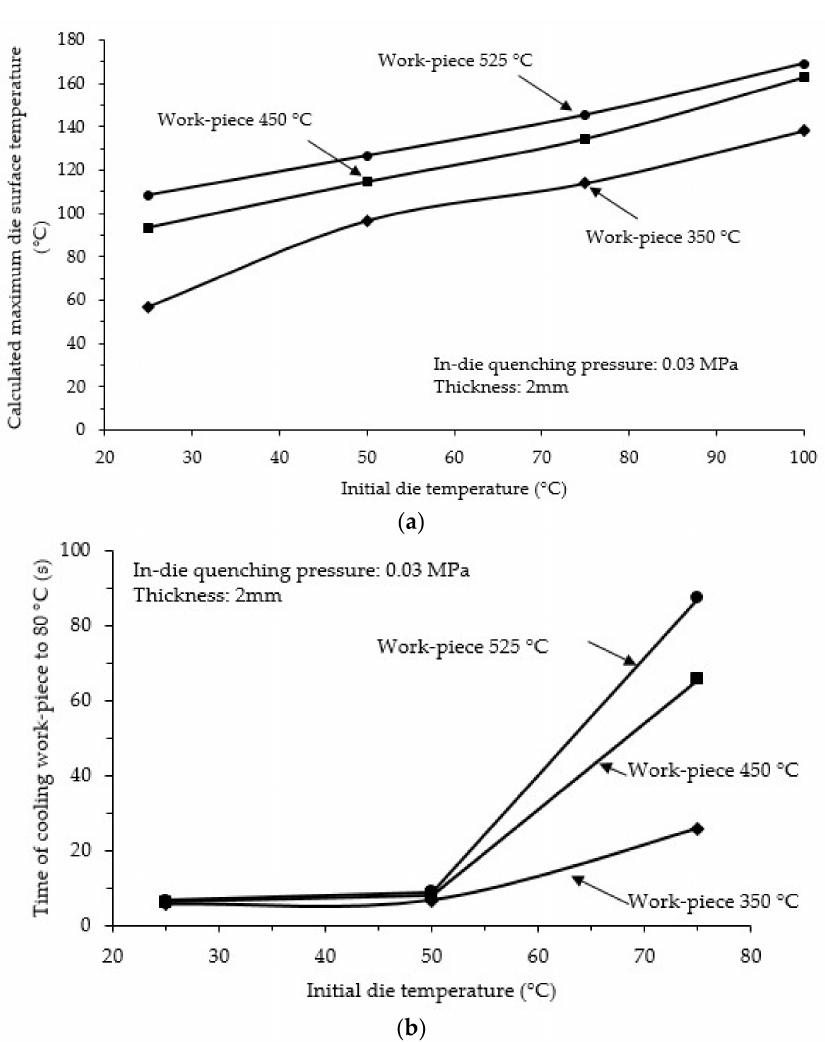
Figure 9. Effects of initial die temperature on the in-die quenching performance. The work-piece thickness was 2 mm. ( a ) Calculated maximum die surface temperature and ( b ) time of cooling work-piece to 80 ◦